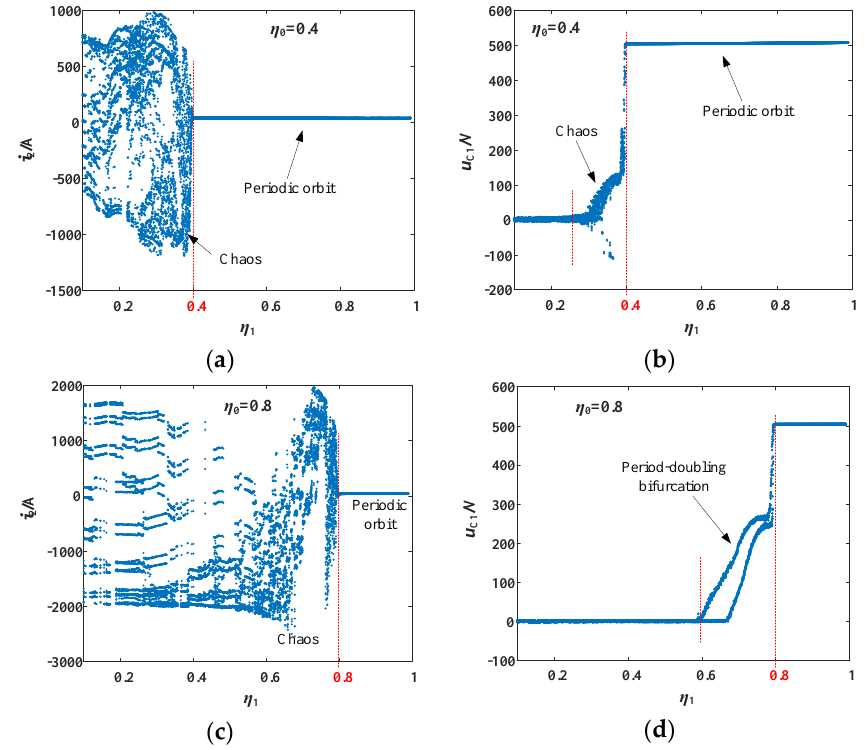
Figure 9. Bifurcation diagrams with η 1 as the bifurcation parameter. ( a ) Bifurcation diagram of the output current 𝑖 2 at η 0 = 0.4 ; ( b ) Bifurcation diagram of the voltage 𝑢 C1 at the output terminals of the photovoltaic array at η 0 = 0.4 ; ( c ) Bifurcation diagram of the output current 𝑖 2 at η 0 = 0.8 ; ( d ) Bifurcation diagram of the voltage 𝑢 C1 at the output terminals of the photovoltaic array at η 0 = 0.8 .